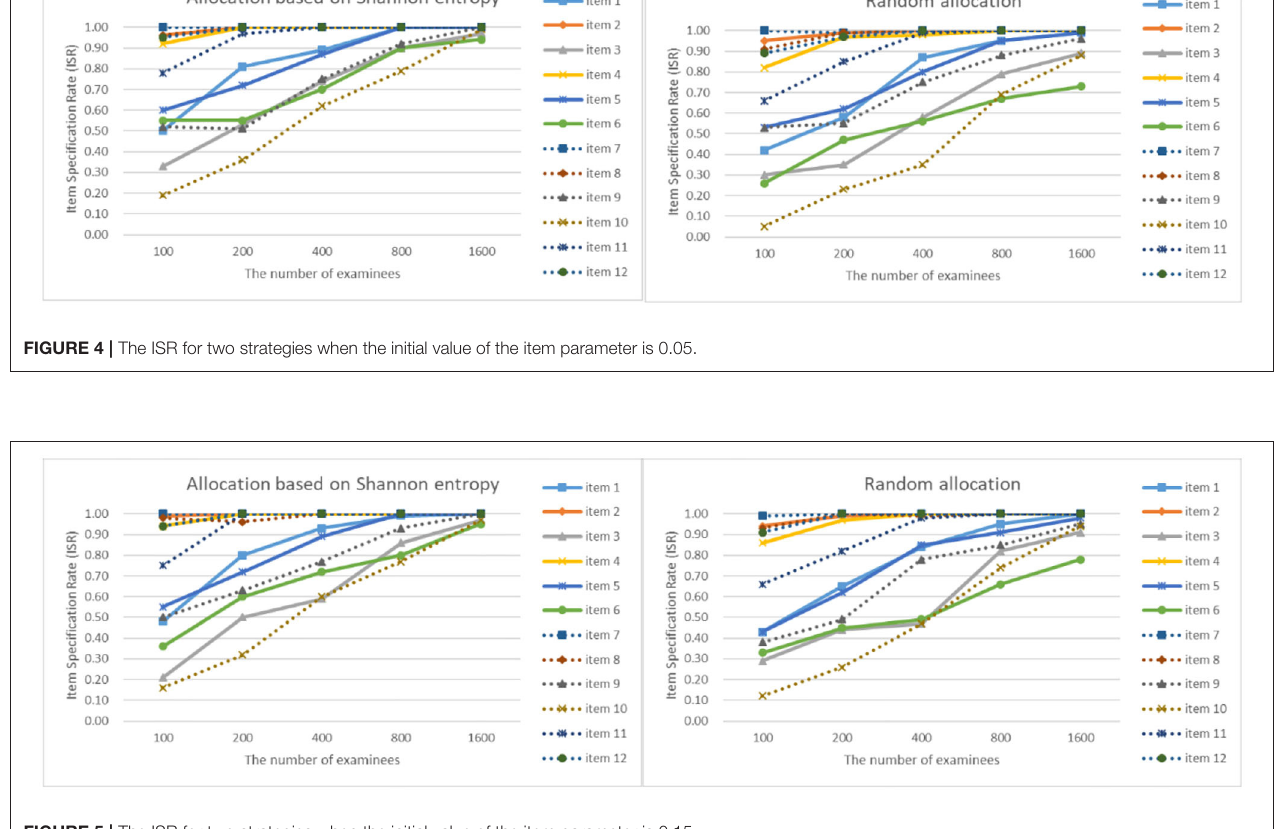
FIGURE 5 | The ISR for two strategies when the initial value of the item parameter is 0.15.